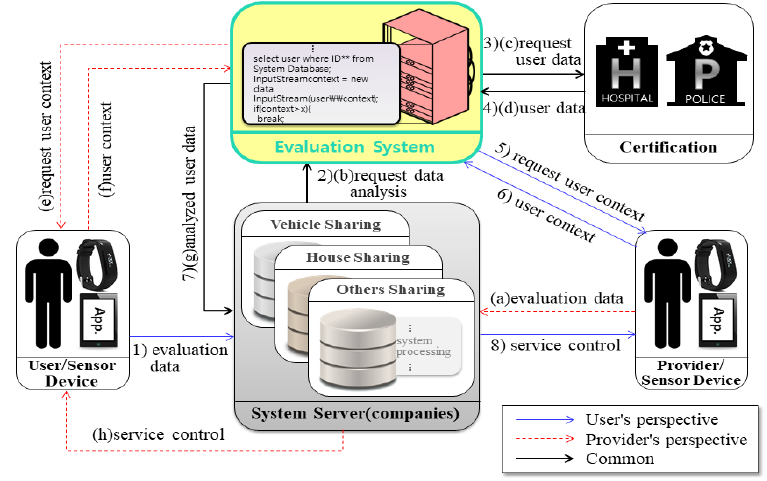
Figure 9. The evaluation system flow for service control.